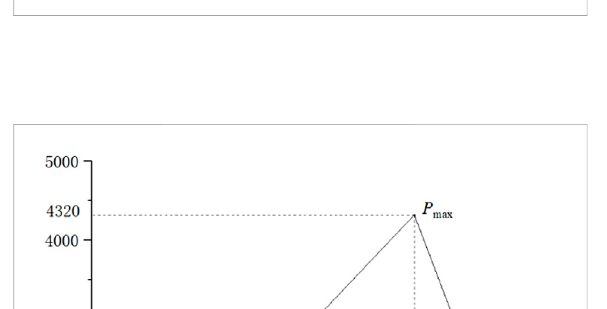
FIGURE 15 Distribution nephogram of the plastic zone after slope strength reduction.